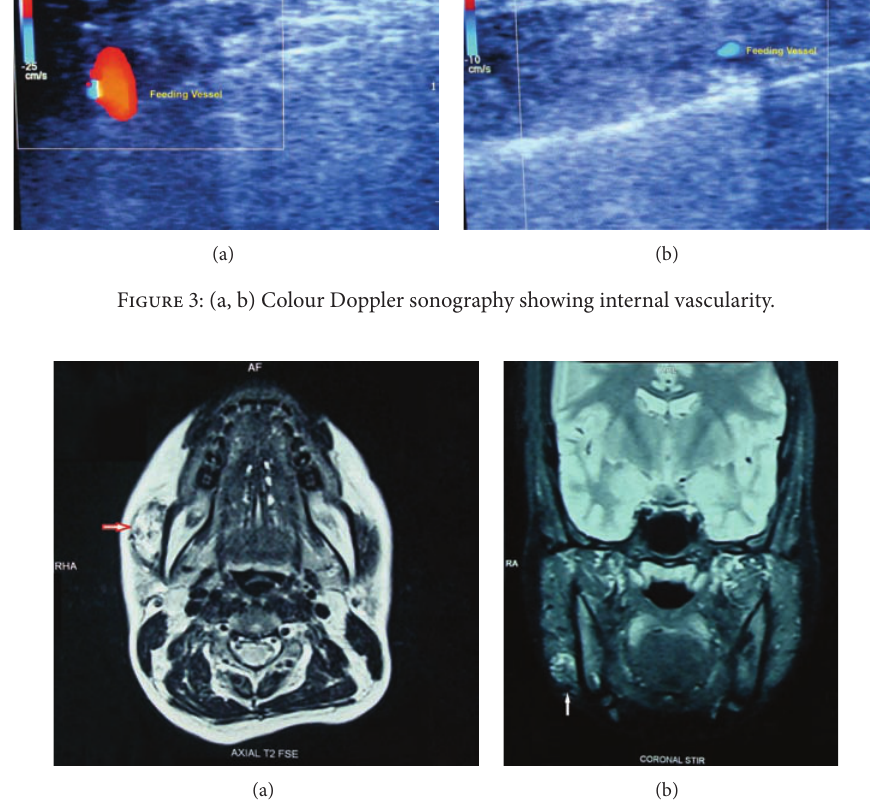
Figure 4: (a) T2 weighted axial view, MRI showing mixed hypo and hyperintense mass, along the anteroinferior aspect of the right masseter. (b) T2 weighted, fat suppressed coronal view of the lesion in right masseter.